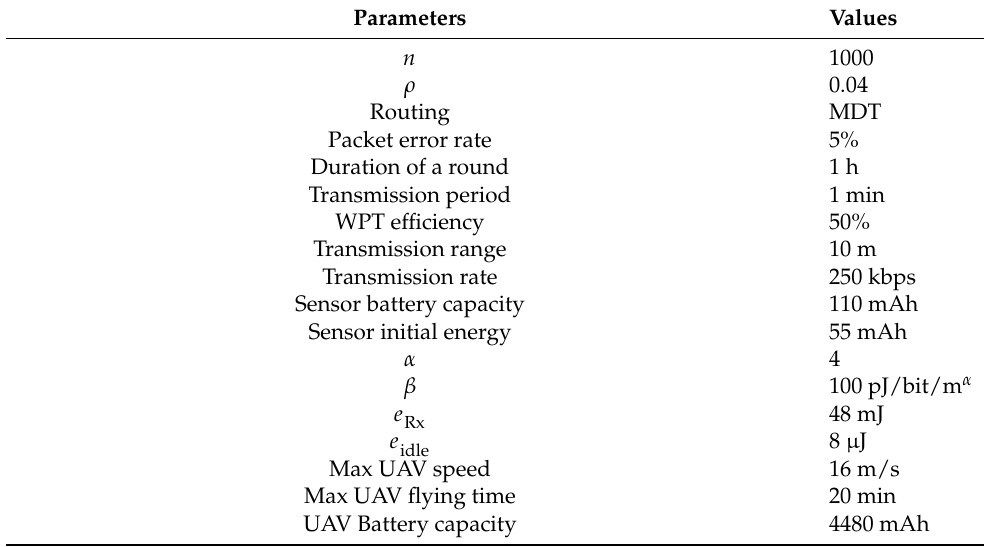
Table 1. Simulation